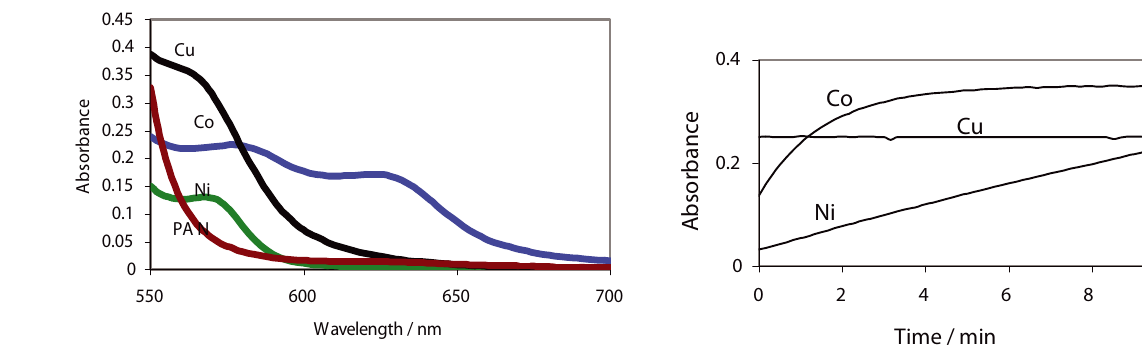
Figure 1. Absorbtion spectra of a 1.0 ° —10 -3 mol L -1 of PAN solution and its complexes with 1.5 μg mL -1 each of of Co(II), Cu(II) and Ni(II).